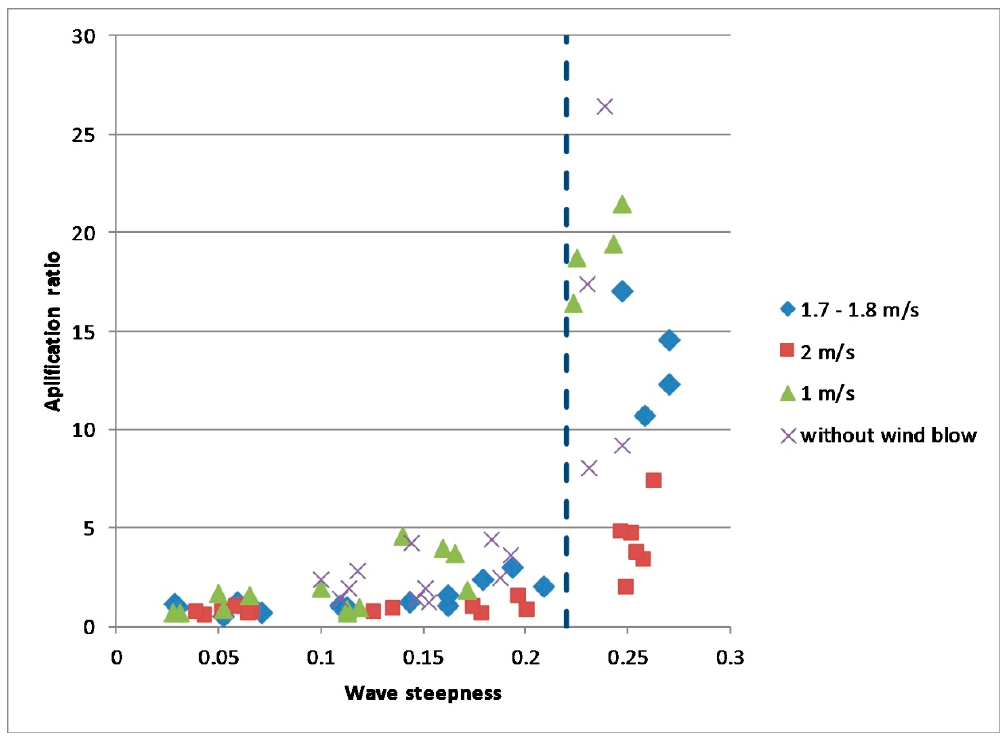
Figure 15. Normalized energy of turbulence in the upper water layer vs. LF wave steepness. Wave breaking occurs at LF wave steepness values exceeding some critical level (dashed line).